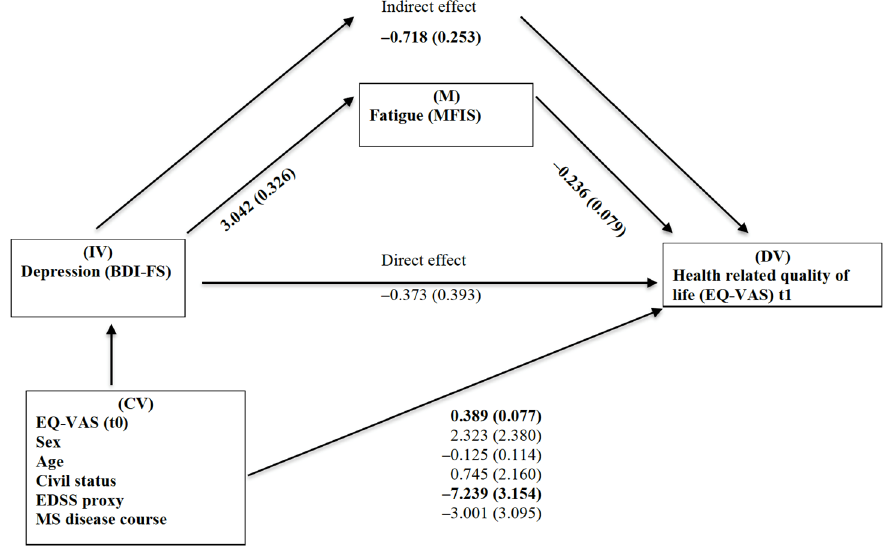
Figure 2. Path analysis of the psychological predictors of depression and fatigue for health-related quality of life (EQ-VAS) in persons with MS ( n = 206). The values on the arrows are unstandardized parameter estimates with standard errors. Bold indicates significance ( p < 0.05). Abbreviations: IV = independent variable; DV = dependent variable; M = mediator; CV = covariates; MS = multiple sclerosis; BDI-FS = Beck Depression Inventory-Fast Screen; MFIS = Modified Fatigue Impact Scale; HRQoL = health-related quality of life; EQ-VAS = European Quality of Life 5-Dimension 5-Level version visual analogue scale; and EDSS = Expanded Disease Status Scale.